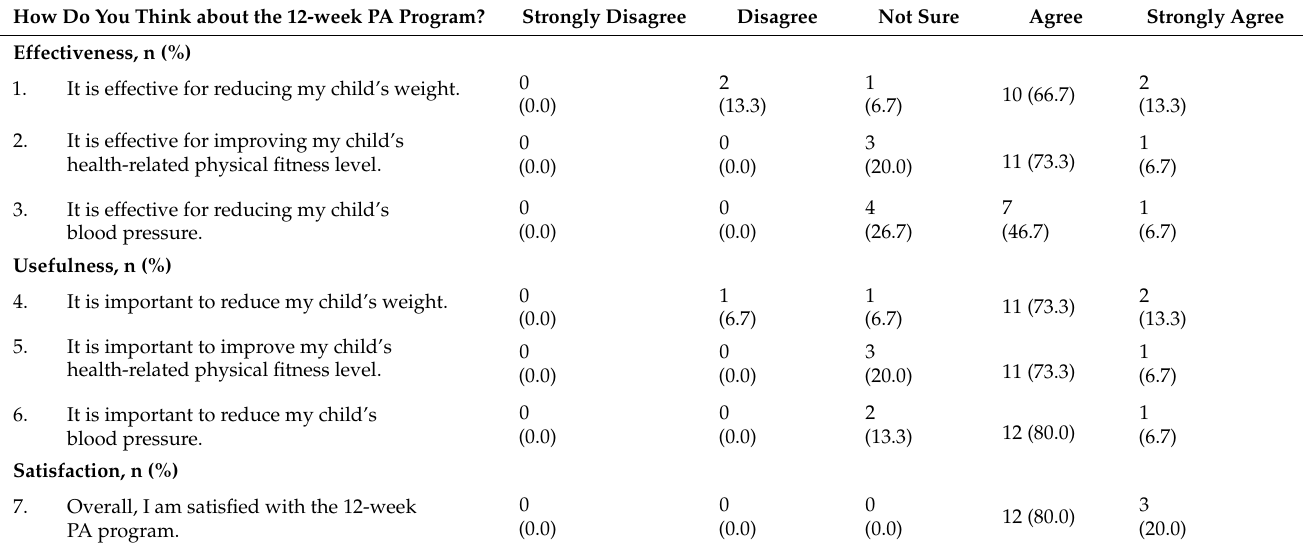
Table A4. Parental feedback on the effectiveness, usefulness, and satisfaction of the 12-week physical activity programme (n =